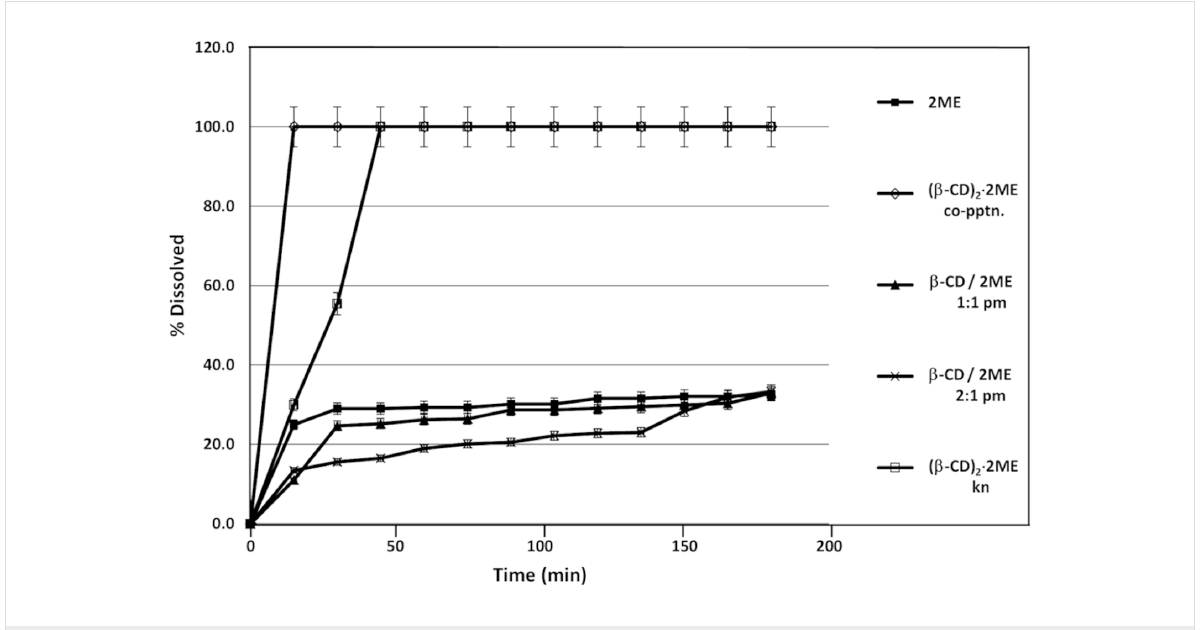
Figure 8: Dissolution profiles in water at 37 °C for untreated 2ME and various β -CD-containing preparations of 2ME.